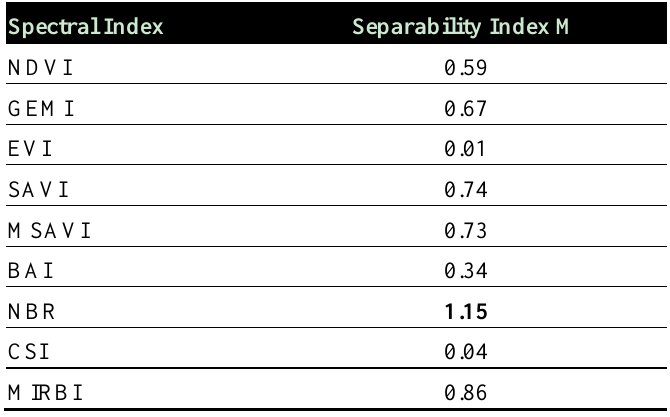
Table 5. Separability index values to discern burned and unburned areas for the spectral indices by using the best performing bands on the pooled dataset (Table 4). Full names are listed in Table 2. Values higher than one are given in